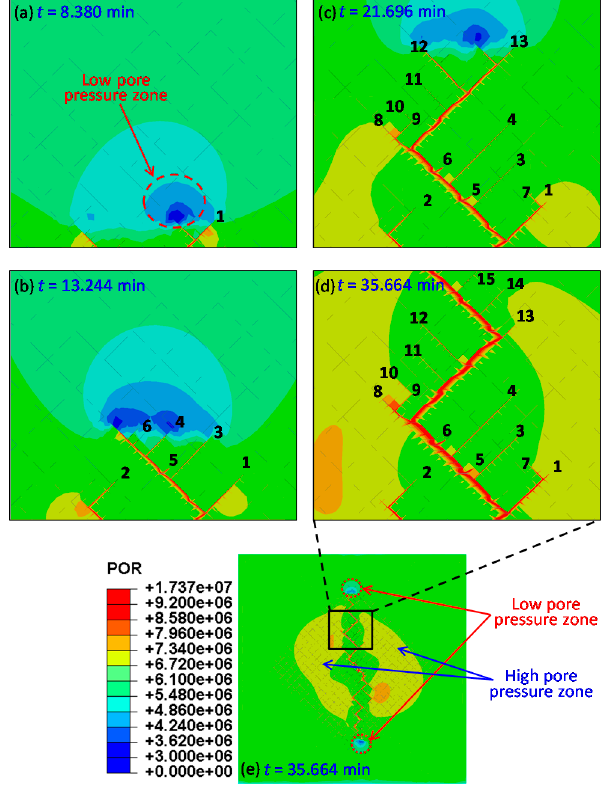
Figure 12. The numerical simulation results for the secondary hydraulic fracture growth process and pore pressure distribution. The serial numbers represent the order of secondary fracture initiation.